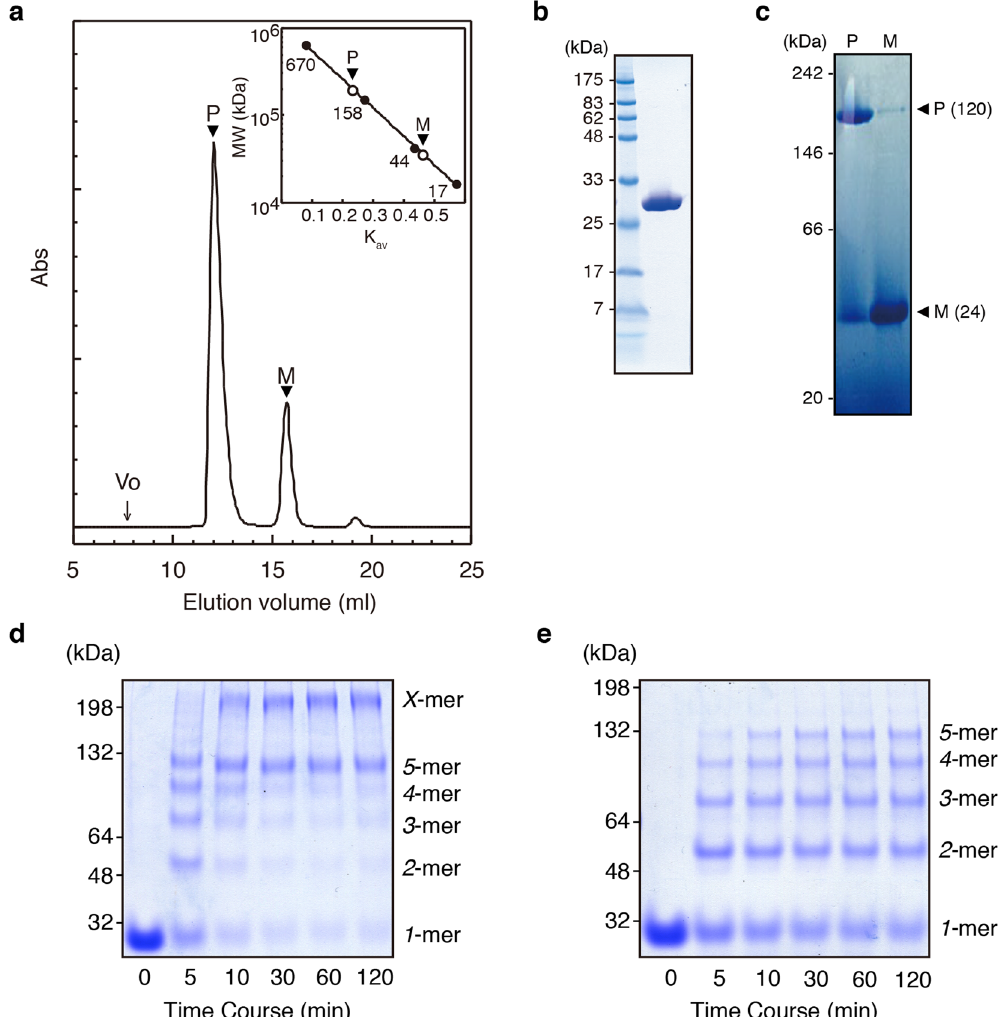
Fig. 1 Biochemical characterization of S. enterica FlgD. a A typical gel- fi ltration pro fi le of puri fi ed FlgD. A FlgD solution was applied on Superdex 200 HR (GE Healthcare) equilibrated with 20 mM sodium phosphate (pH 6.8) containing 150 mM sodium chloride (Vo, void volume; P, pentamer; M, monomer). Inset: estimation of the molecular masses of FlgD pentamer (P) and monomer (M). The molecular size of standard proteins (kDa) was indicated on the left. b SDS-PAGE analysis of puri fi ed FlgD used for gel- fi ltration analysis. Standard molecular masses (kDa) are indicated on the left. c BN-PAGE analysis of the fractions containing the FlgD pentamer or monomer. Standard molecular masses (kDa) are indicated on the left. Chemical cross-linking analyses of puri fi ed FlgD. d , e SDS-PAGE of cross-linked products. Products by EDC with Sulfo-NHS at a molar ratio of 1 : 2000 ( d ), in which a product with a higher molecular weight is indicated as “ X -mer, ” and products by DTSSP at a molar ratio of 1 : 50 ( e ). The molecular weight markers of cross-linked hemoglobin (32, 48 and 64 kDa) and albumin (132 and 198 kDa) were indicated on the